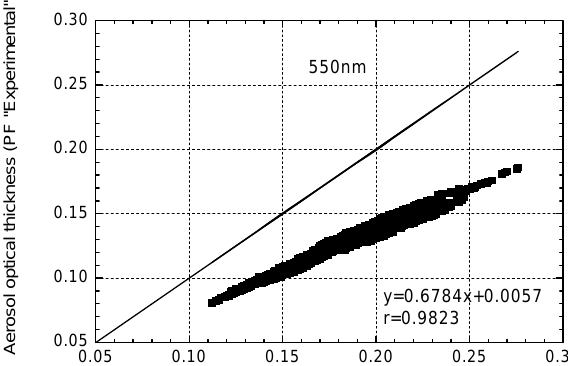
Fig. 20. Comparison of the AOTs (550nm) retrieved by the ART algorithm using Continental and experimental phase functions. r is the correlation coefficient.